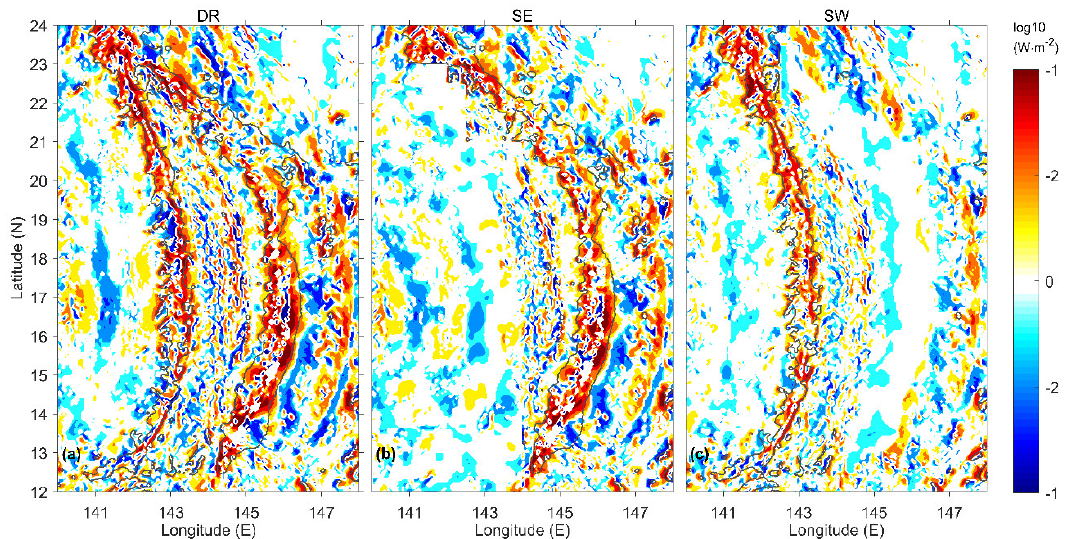
Figure 10. Depth-integrated barotropic-to-baroclinic conversion rates (W m − 2 ) under the DR ( a ), SE ( b ), and SW ( c ) cases. The background black contours represent the 3000-m isobaths.